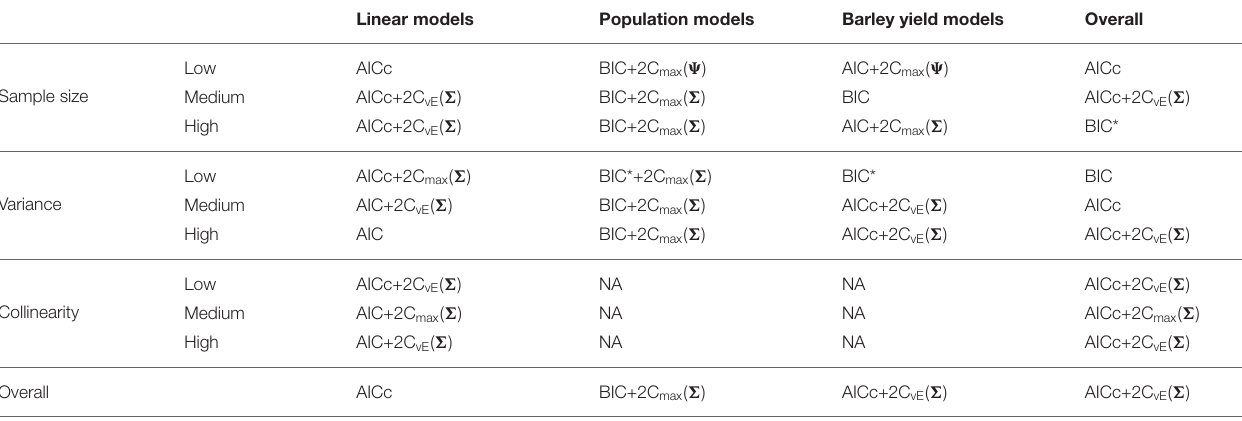
TABLE 4 | Best performing information criteria at selecting the generating model from the candidate set.